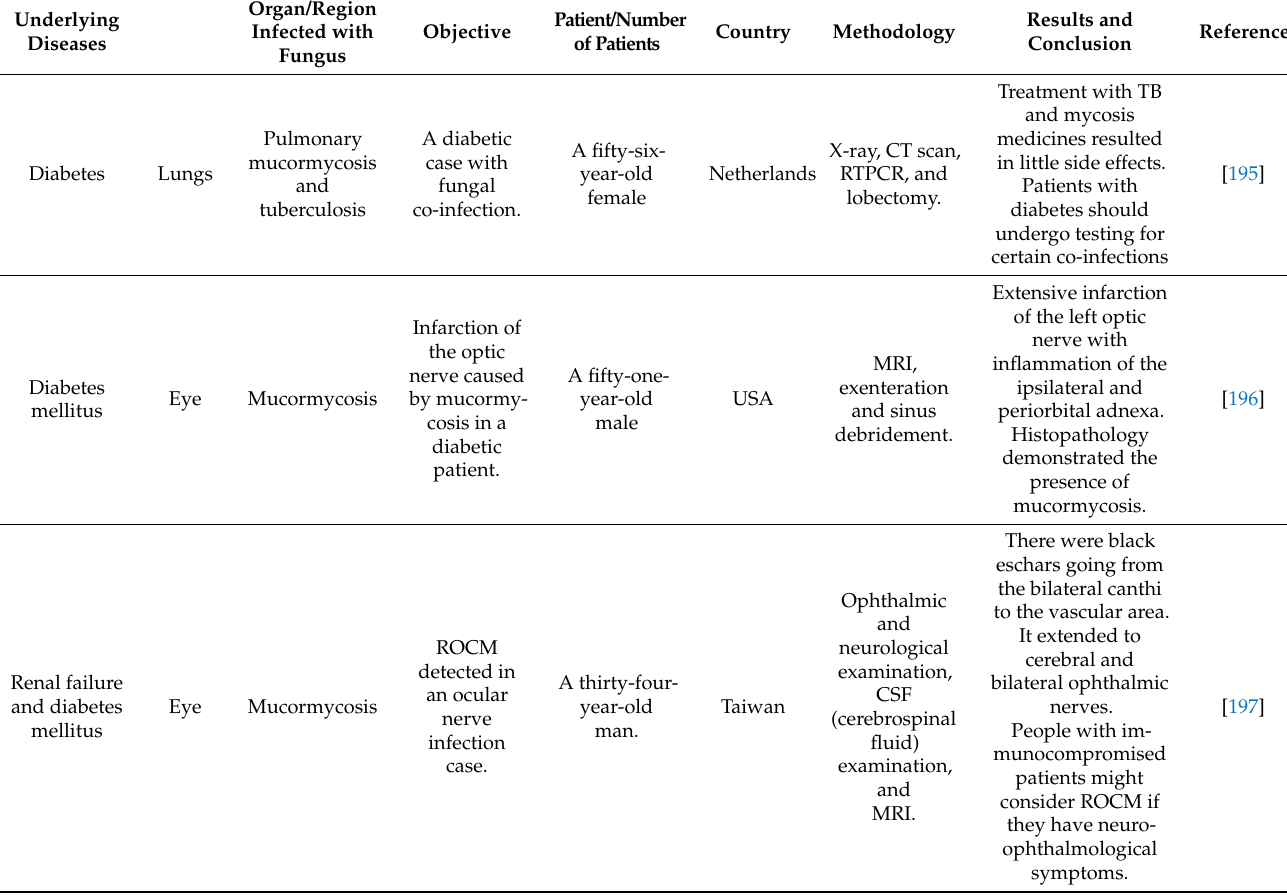
Table 4. Recent studies on mucormycosis cases with diabetic